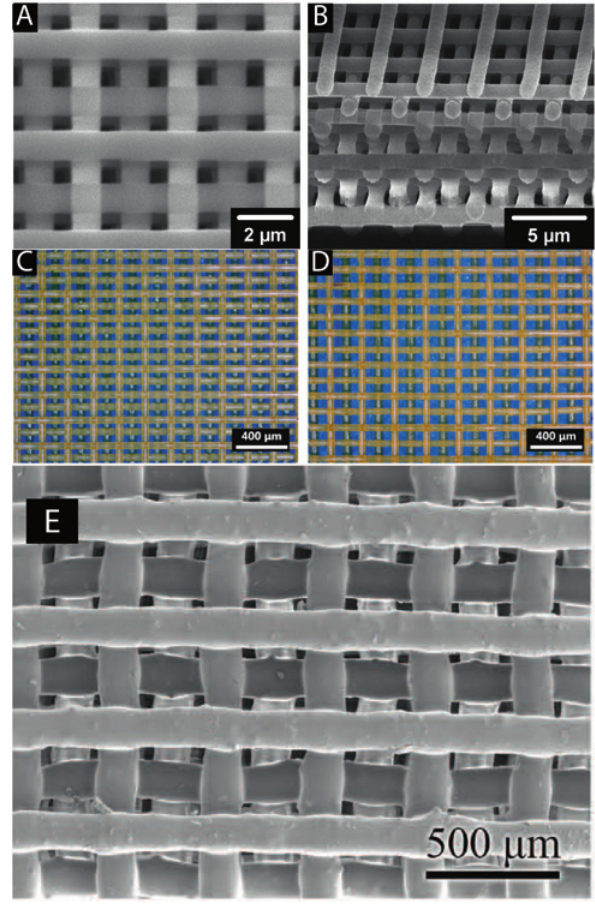
Figure 11: 3D woodpile photonic crystal structures written using DIW. (A – B) SEM images of polymer woodpile structure with 1 μ m diameter rods and center-to-center rod spacing of 4 μ m. Reprinted with permission from Ref. [160]. (C – D) Optical images of sol-gel titanium dioxide (TiO 2 ) woodpile structures with varying lattice periods of 200 μ m (C) and 250 μ m (D). Reprinted with permission from Ref. [165]. (E) SEM image of woodpile structure written using 40wt%BaTiO 3 /PDMScompositeinkanda180 μ mnozzle.Reprinted with permission from Ref.